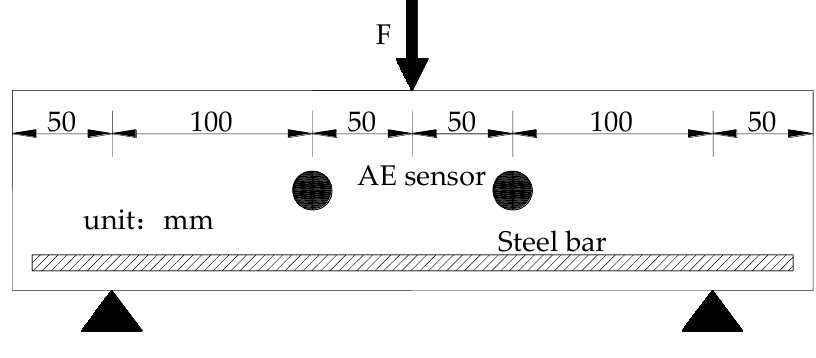
Figure 3. Schematic diagram of flexural strength test.